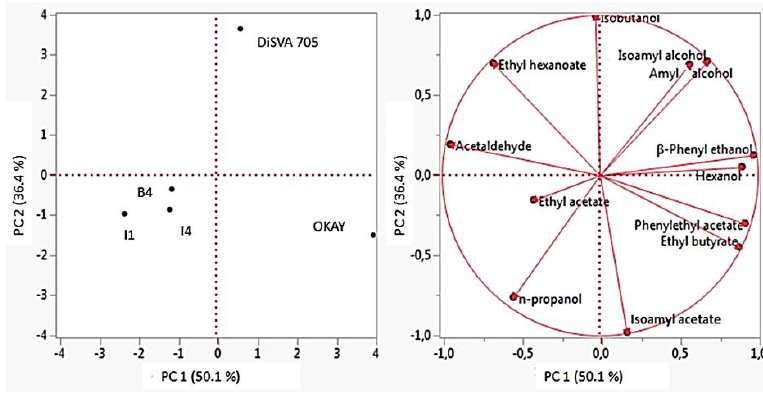
Figure 5. Principal component analysis based on the data for the main byproducts of fermentation and volatile compounds in the wines obtained NGJ.